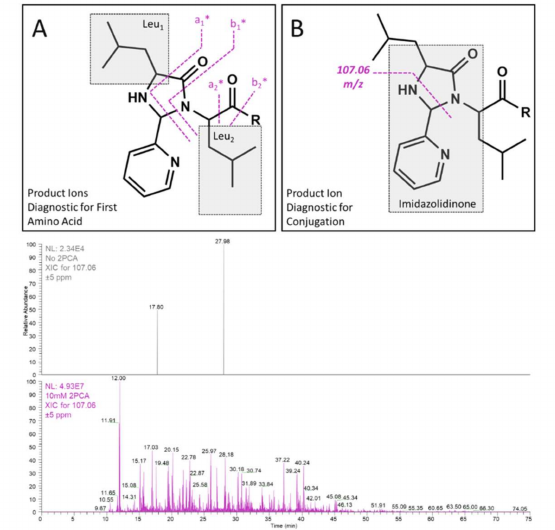
Figure 2. Fragmentation schema that produce diagnostic product ions for the identification of the first amino acid ( A ) and for imidazolidinone formation, in general, are shown ( B ). Extracted ion chromatograms for the m / z 107.06 ± 5 ppm peak are shown for the control sample in the absence of 2PCA (top chromatogram) and after incubation with 10 mM 2PCA (bottom chromatogram). Note the difference in the base peak